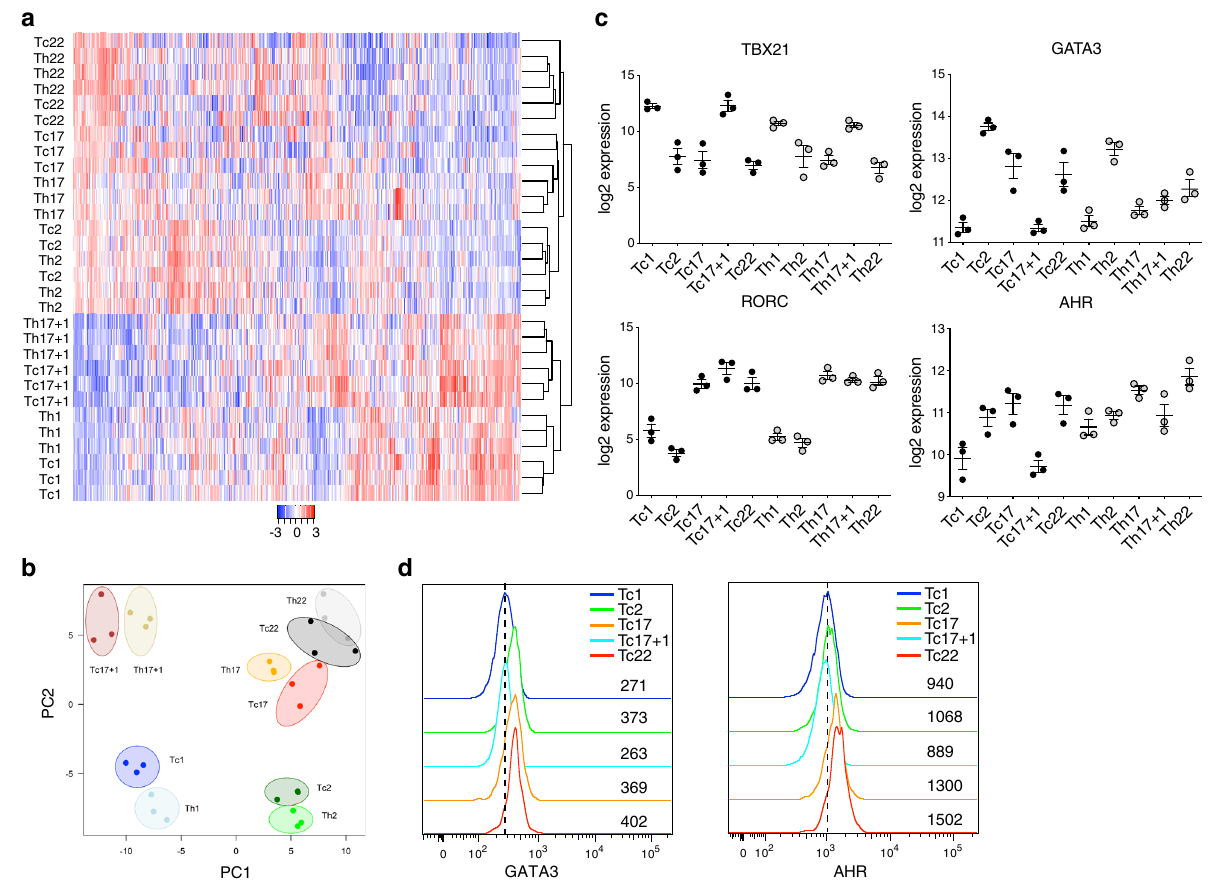
Fig. 2 CD4 + Th- and respective CD8 + Tc-cell subsets utilize the same differentiation programs. a Heatmap of the top 1000 most variable expressed genes of sorted CD8 + and CD4 + memory T-cell subsets as shown in Fig. 1a after normalization and batch compensation (number of donors = 3). b Principal component analysis of all protein-coding expressed genes. c Normalized, log2-transformed expression of indicated transcription factors among Tc- (black circles) and Th- (gray circles) cell subsets, mean ± SEM. d Representative histogram of intracellular staining for transcription factors GATA3 and AHR in CD8 + CD45RA − Tc-cell subsets. Numbers in plots indicate the